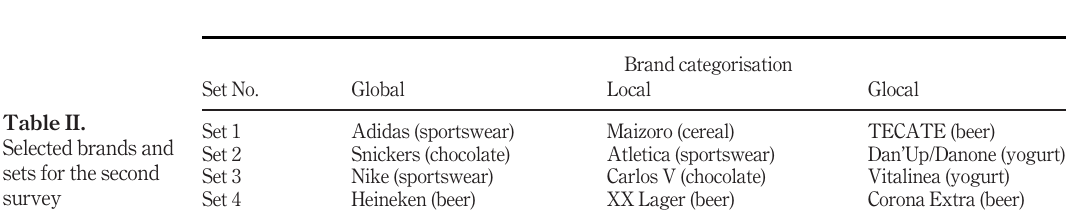
Table I. Distribution of the sample by age and gender compared to the population of Mexico